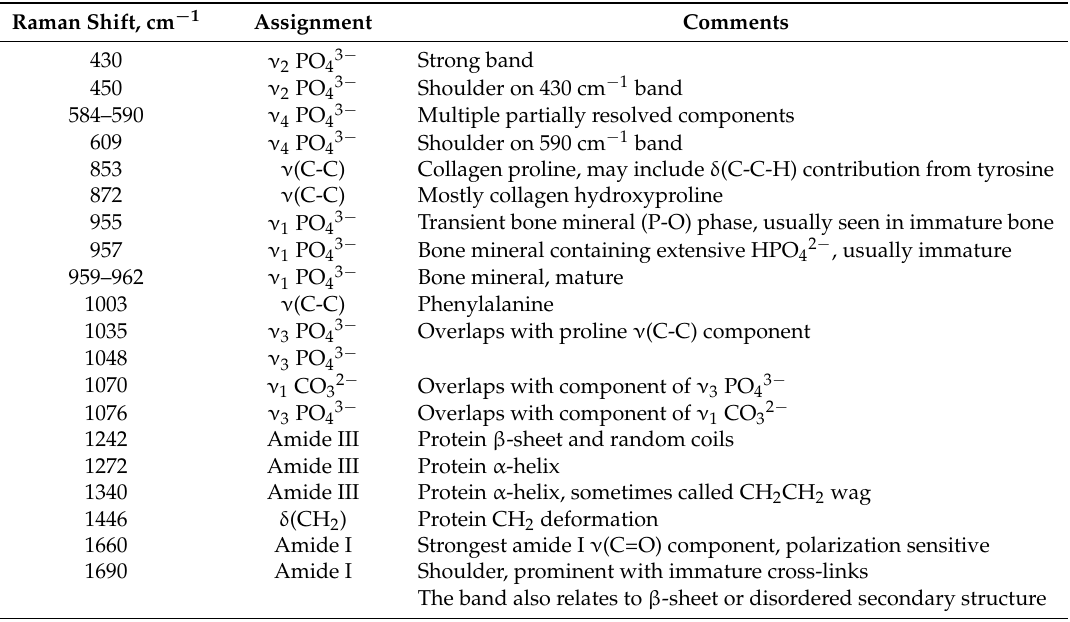
Transient bone mineral (P-O) phase, usually seen in immature bone 957 ν 1 PO 43 − Bone mineral containing extensive HPO 42 − , usually